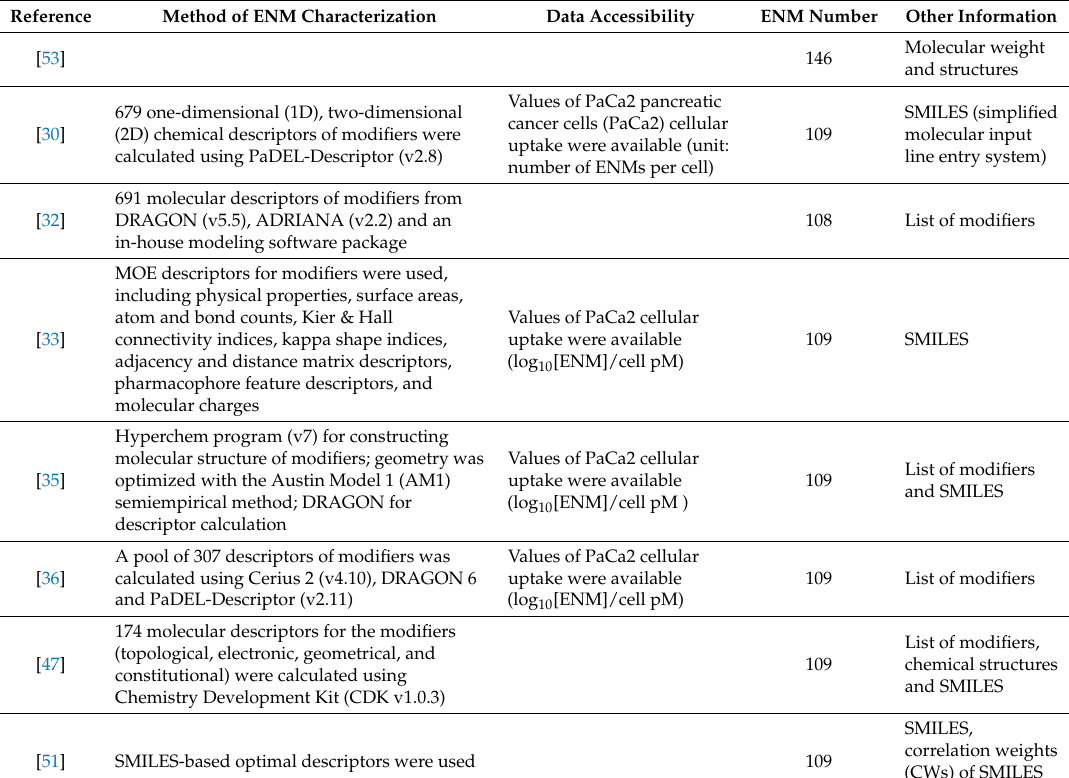
Table 3. Overview of reported information of the data published by Weissleder et al.